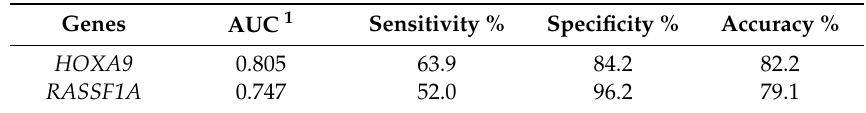
Table 4. Biomarker performance of promoter gene methylation for SCLC detection in study group #2 (plasma samples).